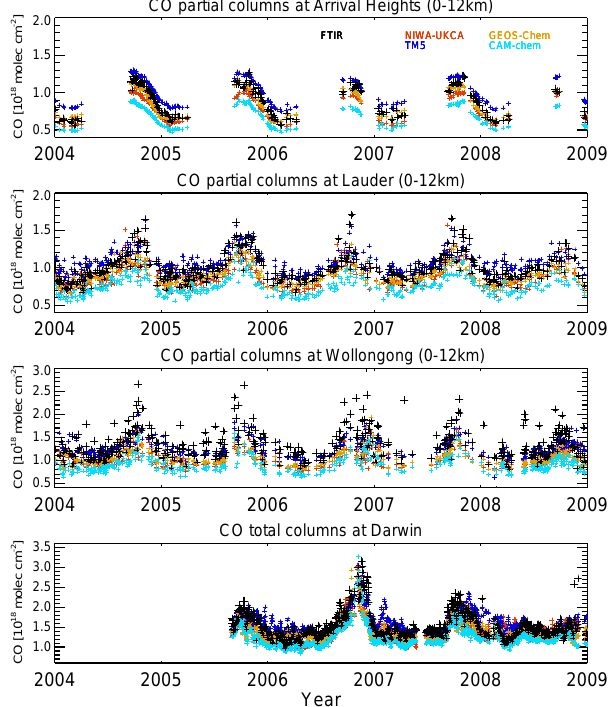
Figure 3. Modelled and observed daily-mean FTIR CO columns at SH stations from four models. Simulations use CLM-MEGANv2.1 biogenic